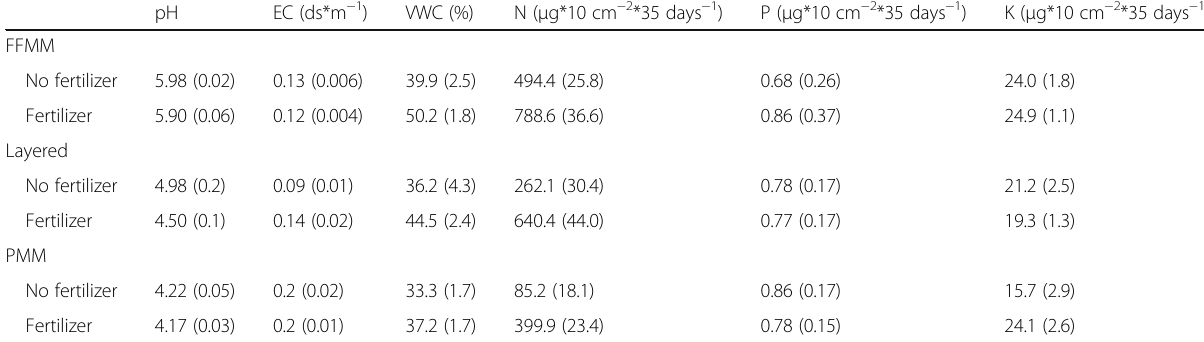
Table 1 Soil properties of control pots (i.e. with no plants). Values are means and standard error